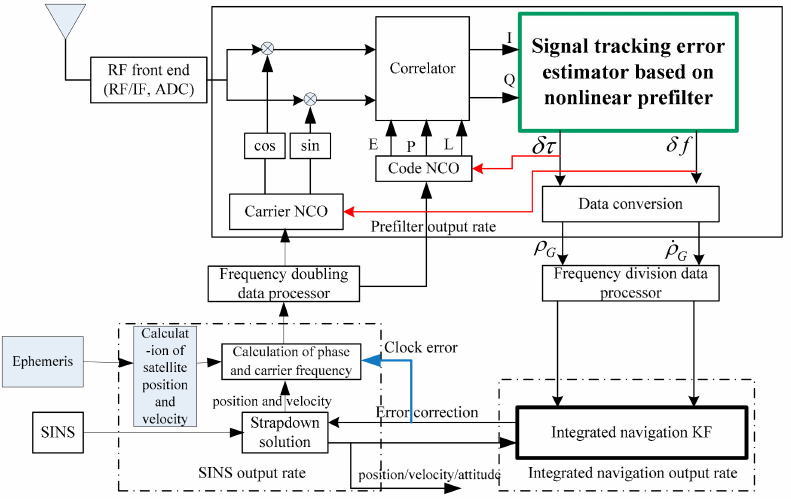
Figure 1. SINS/GPS federated ultra-tightly coupled structure based on double